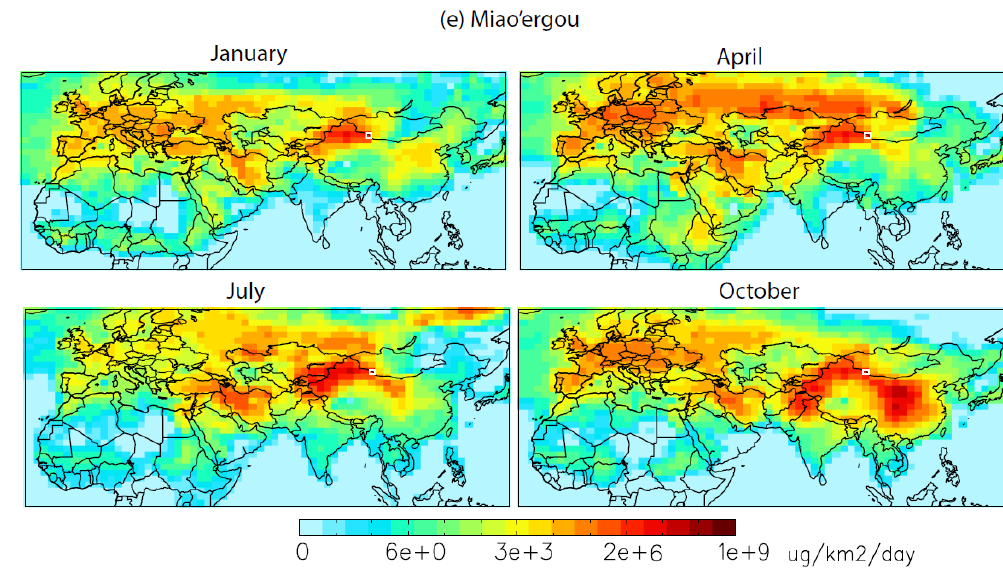
Figure 5 Origin of black carbon by season (January, April, July, October) at five glacier sites throughout the Third Pole (a) Mt. Everest (Himalayas), (b) Zuoqiupu glacier (southeastern Tibetan Plateau), (c) Meikuang (northeastern Tibetan Plateau), (d) Mt. Muztagh (western Tibetan Plateau), and (e) Miao’ergou (north of Tibetan Plateau). The grid box containing each glacier site is outlined in white. The quantity of BC arriving at each glacier grid box from each grid box in the domain is indicated in